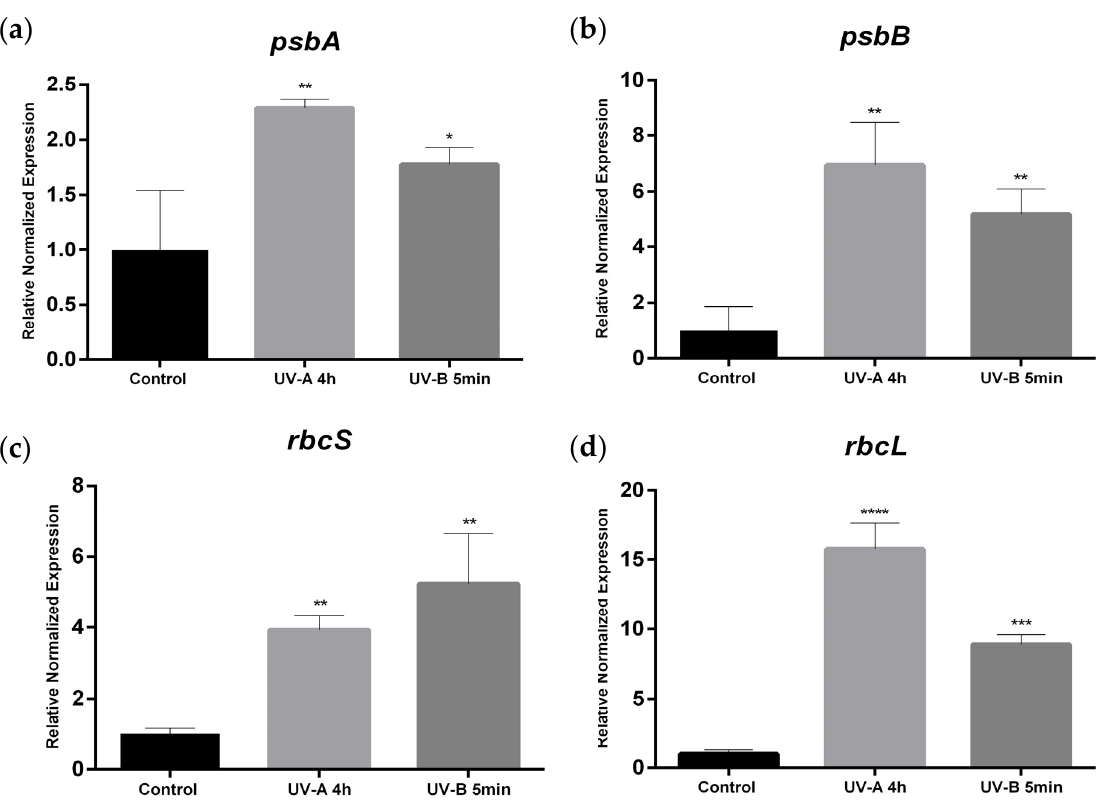
Figure 4. Regulation of photosynthesis pathway genes by different UV-A/B conditions. All parameters were measured in control, UV-A 4 h and UV-B 5 min (the last two are the higher exposure times for each radiation). The relative expression of the photosynthetic components was determined for psbA ( a ) and psbB ( b ) which encodes the D1 protein and CP47, respectively. At the same time, the relative expression of the genes encoding for the two subunits of RuBisCO were also assessed: rbcS ( c ) and rbcL ( d ) for small and large subunits, respectively. Within each parameter, *, **, *** and **** represent significant differences for p < 0.05, 0.01, 0.001 and 0.0001, respectively. Values are expressed as the mean and standard deviation. (n =